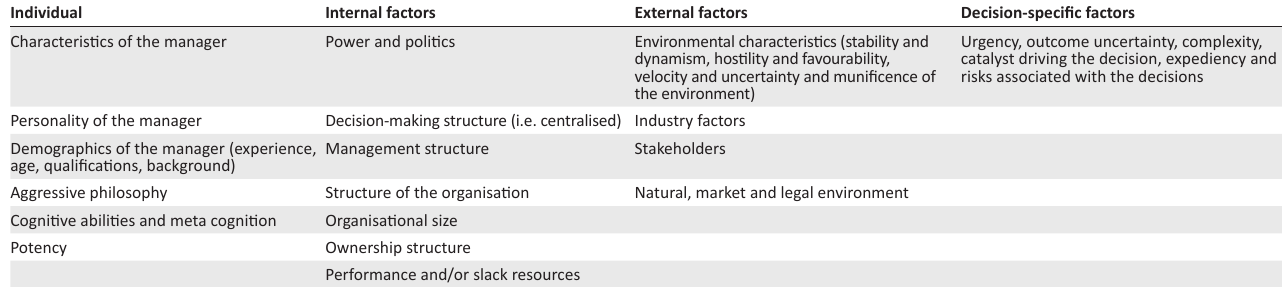
TABLE 1: Influencing factors in strategic decision making.